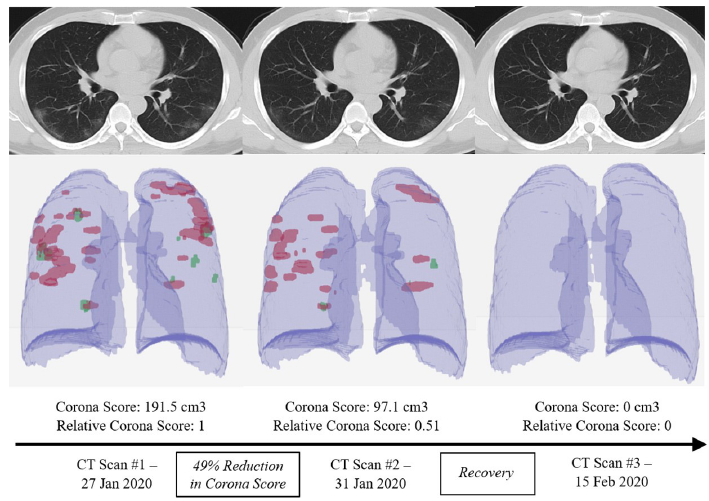
Figure 2. Using different computed tomography (CT) scans from a a COVID-19 patient, the RAD- Logics algorithm measures the recovery amount using a specific score